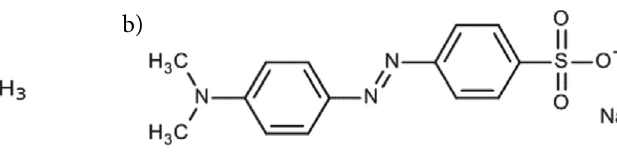
Figure 1. The molecular structure of MB (a) and MO (b).